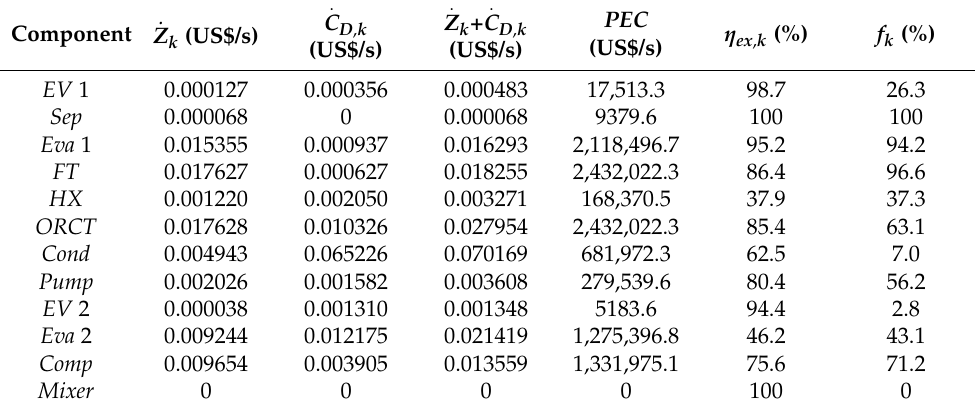
Table 14. The exergo-economic parameters of the